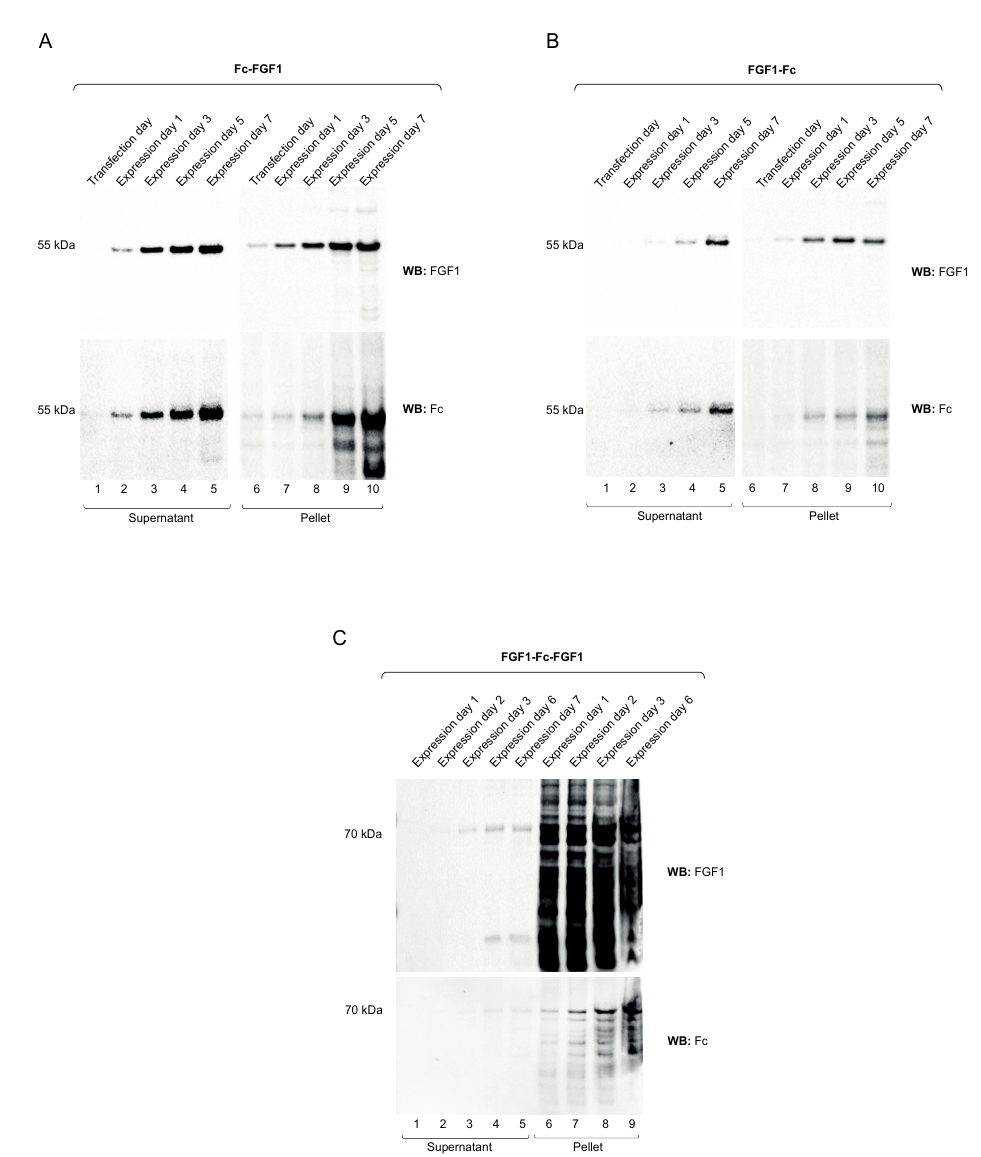
Figure 2. Expression of FGF1-fused to the Fc. Recombinant proteins: Fc-FGF1 ( A ), FGF1-Fc ( B ) and FGF1-Fc-FGF1 ( C ) were expressed in CHO-S cells. Levels of FGF1 variants at different stages of protein expression was monitored by Western blotting with antibodies recognizing FGF1 and Fc fragment.